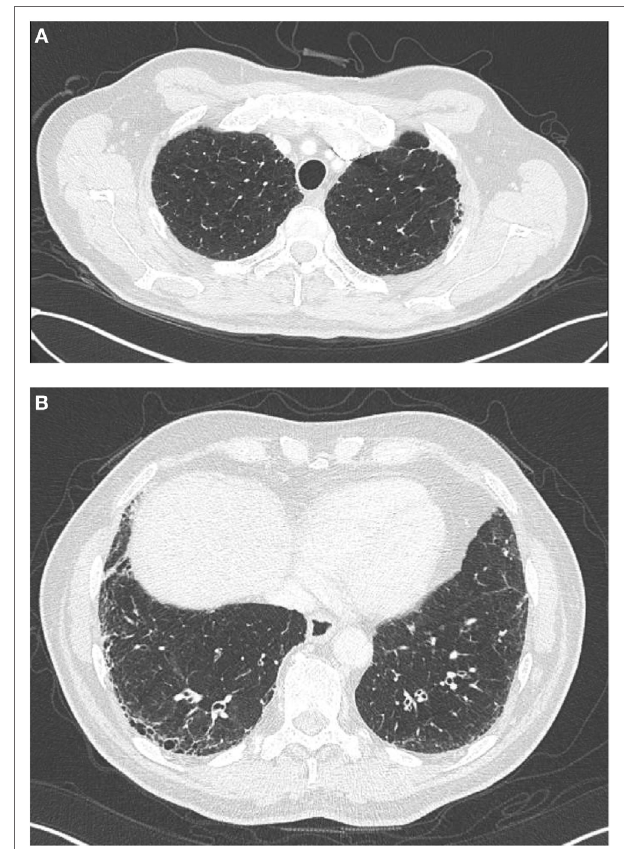
FigURe 1 | High-resolution computed tomography findings in a patient, with combined pulmonary fibrosis and emphysema. Centrilobular emphysema is observed on apical views (A) and basilar predominant sub-pleural reticulation and honeycombing characteristic of UIP is observed on basilar views (B)